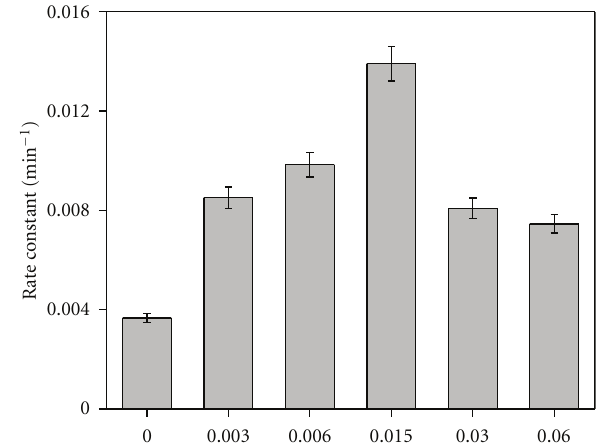
Figure 7: Dependence of apparent rate constants ( k ) of the Au-TiO 2 composite samples on the R Au